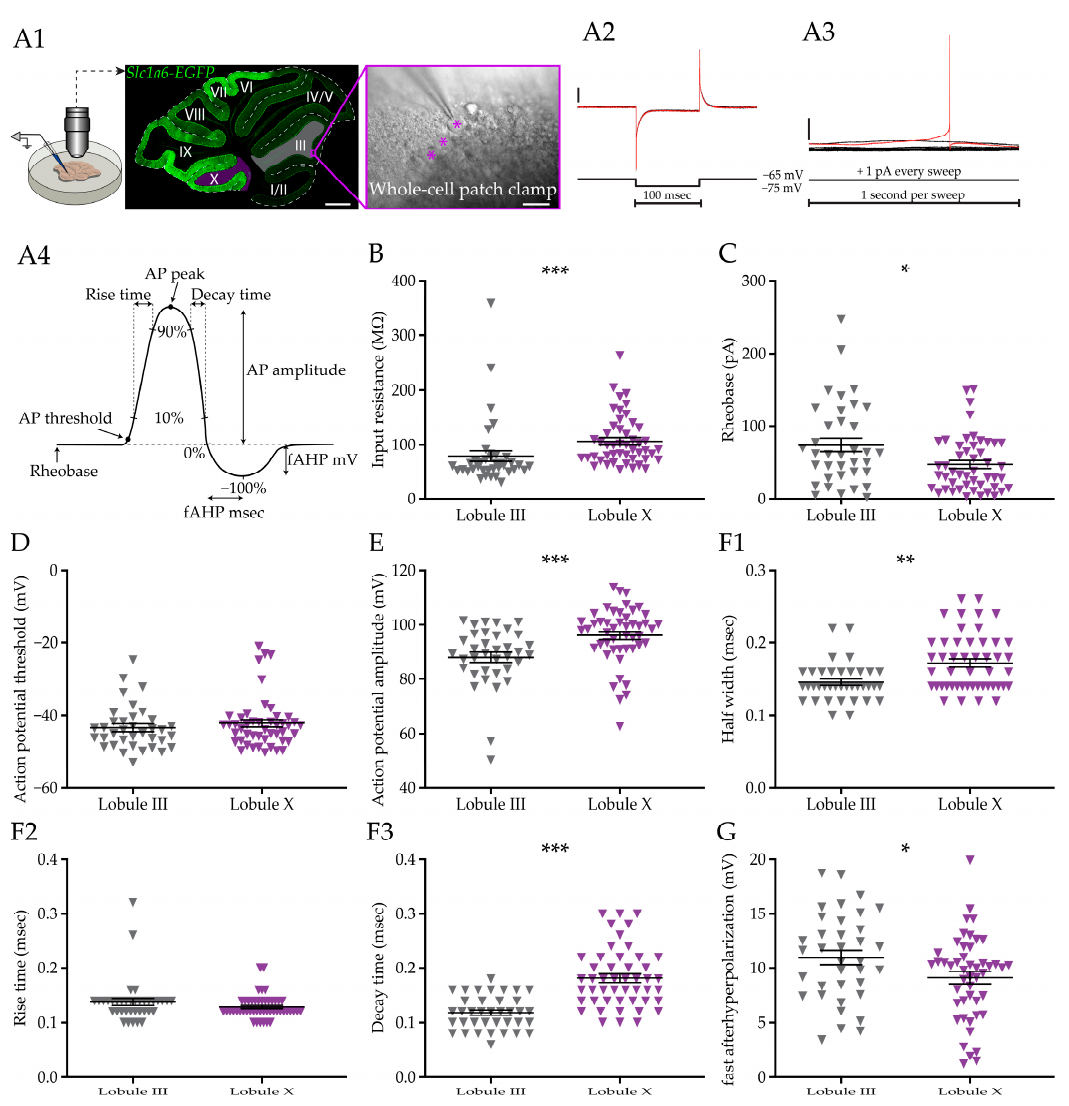
Figure 1. Cellular properties and Purkinje cell action potential shape in different subpopulations. ( A ), Schematic depiction of the recording approach with example image of recorded neurons and a view of a sagittal cerebellar brain slice of a Slc1a6 ‐ EGFP mouse (Roman numerals indicate lobule number) ( A1 ) and methods to determine various parameters, including negative currents pulses ( A2 ), slowly ramping holding current ( A3 ) and demarcation of various parameters ( A4 ). ( B – E ), Analysis of input resistance, rheobase, action potential threshold, and AP amplitude for each sub ‐ population in mice of >P30. ( F ), Action potential duration analysis, examining half width ( F1 ), rise time ( p = 0.1621) ( F2 ) and decay time ( F3 ) for each subpopulation. Note that, due to their low values, these parameters reveal the sample rate (50 kHz), resulting in a step ‐ wise patterns of values. ( G ), Plot of the amplitude of the fast after hyperpolarization (in mV). Scale bar in A1 ‐ Slc1a6 ‐ EGFP , 100 μ m; ( A1 ) Whole ‐ cell patch clamp 30 μ m; ( A2 ) vertical scale bar 200 pA; ( A3 ) vertical scale bar 20 mV. Asterisks denote: * for p < 0.05, ** for p < 0.01 and *** for p < 0.001. See Table S1 for all statistical data.